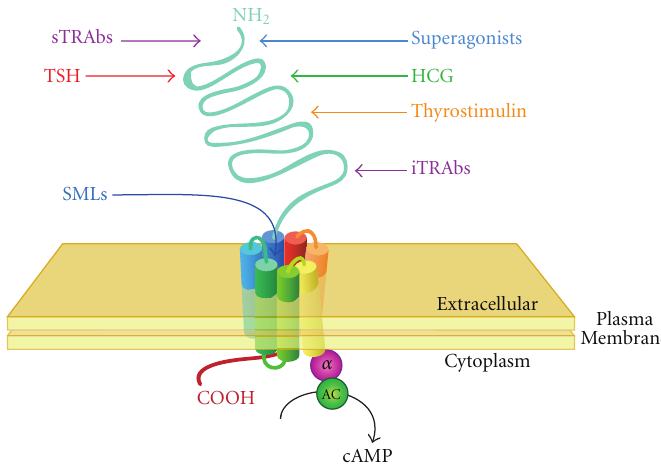
Figure 8: Interaction of TSH, thyrotropic agonists, and thyrotropic antagonists with TSH receptor. SMLs bind to a pocket within the heptahelical transmembrane domain, while TSH, HCG, and TRAbs bind primarily to the TSHr amino-terminal